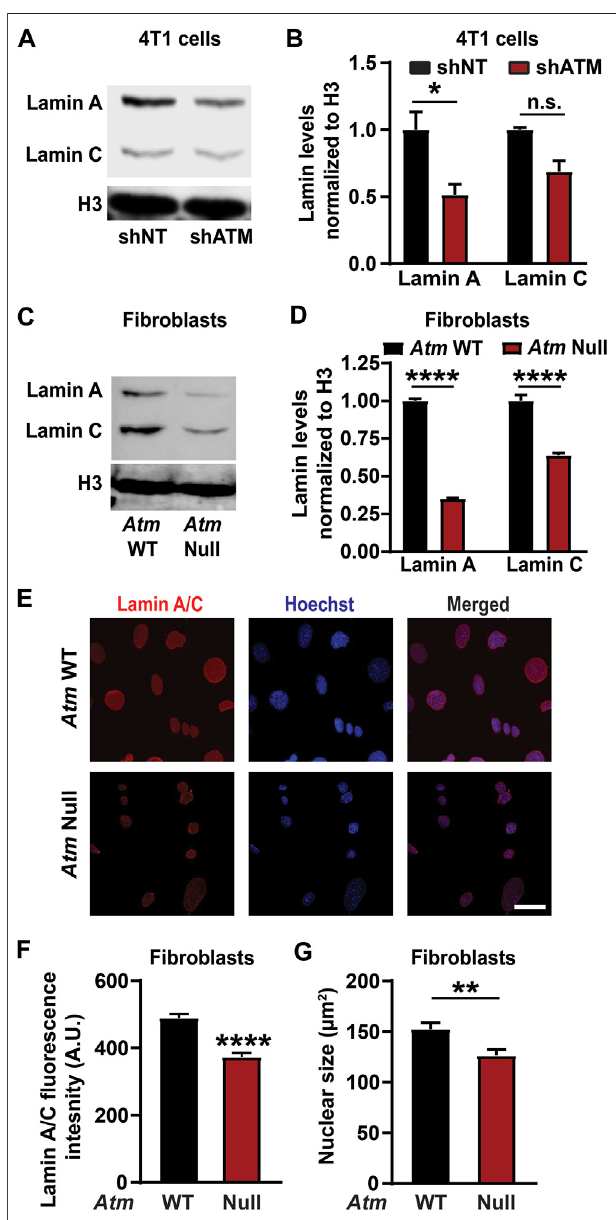
FIGURE 2 | ATM deletion and depletion reduce lamin A levels. (A) Representative immunoblot for lamin A and lamin C of 4T1 cells with doxycyclineinducedATMdepletionbyshRNA(shATM)andnon-target(shNT) controls following 4 days of treatment with doxycycline. Histone H3 was usedasloadingcontrol. (B) Correspondingquanti fi cationofthelaminAandC levelsbasedonthreeindependentexperiments.Laminlevelswerenormalized to shNT cells. *, p < 0.05 based on Two-way ANOVA with Tukey ’ s multiple comparison test. N = 3. (C) Representative immunoblot for lamin A and lamin